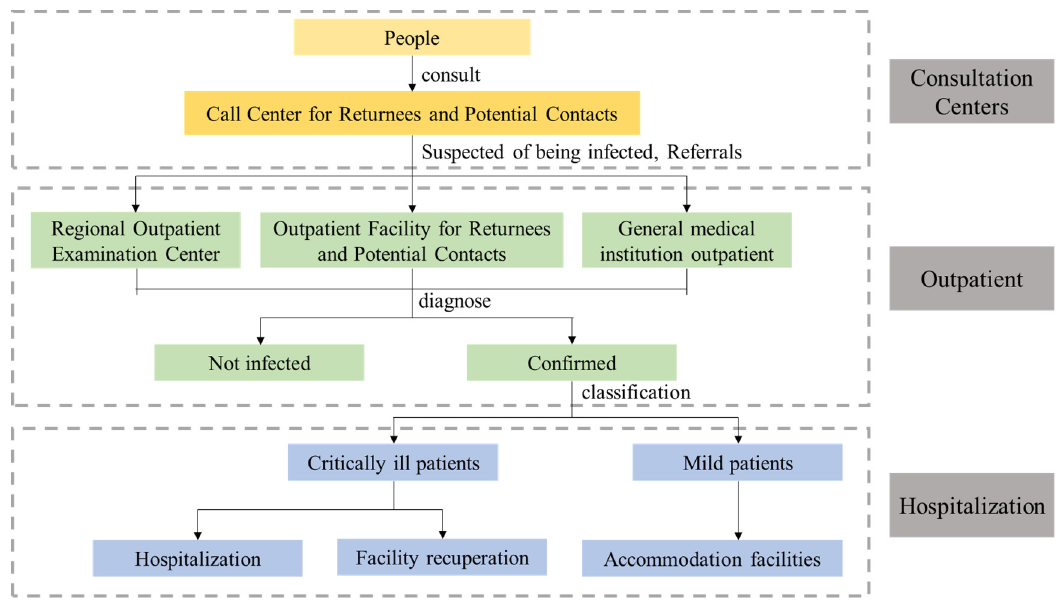
Figure 5. Japan’s emergency medical service system.